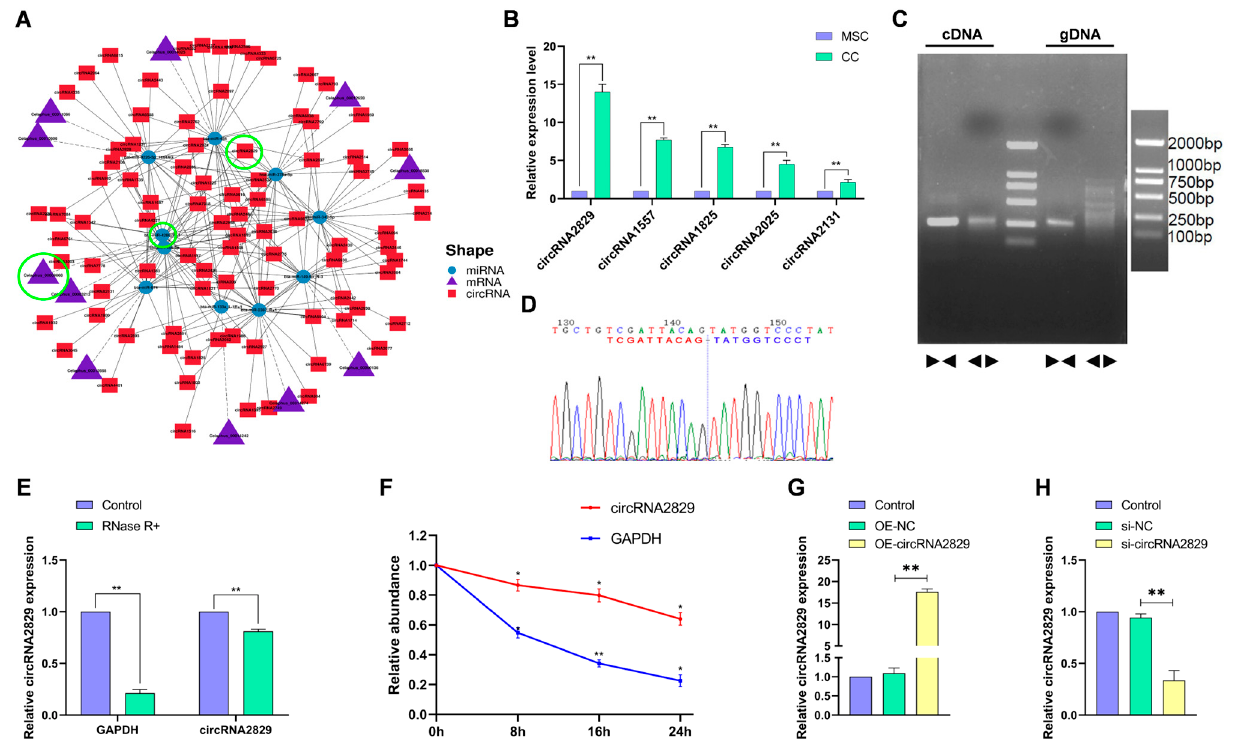
Figure 5. circRNA2829 was identified as a circular RNA related to antler regeneration and differentiation. ( A ) The circRNA-miRNA-mRNA interaction network is related to the development and regeneration of antlers. ( B ) The top five circRNA in the ceRNA network with relative expression levels were detected by RT-qPCR. ( C ) The agarose gel electrophoresis was performed using divergent primers and convergent primers to verify the existence and circular structure of circRNA2829. ( D ) Sanger sequencing was used to validate that the back splice site existed. ( E , F ) Relative expression levels of GAPDH and circRNA2829 after RNase R treatment or after Act-D treatment were examined by RT-qPCR. ( G , H ) Relative expression levels of circRNA2829 were detected by RT-qPCR after treatment of chondrocytes with OE-circRNA2829 or si-circRNA2829. ** p < 0.01, * p < 0.05.